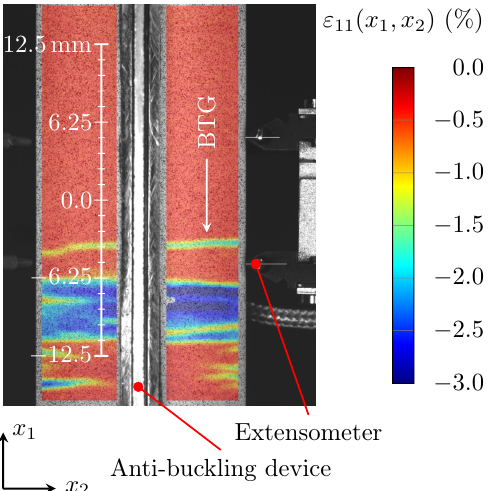
Figure 9. Strain field ε 11 ( x 1 , x 2 ) of a hot-bent uniaxial specimen with an extensometer strain ε 11,ext = 0.45% measured with DIC. The BTG, the anti-buckling device, and the extensometer − are marked. The length scale starts at the beginning of the transition